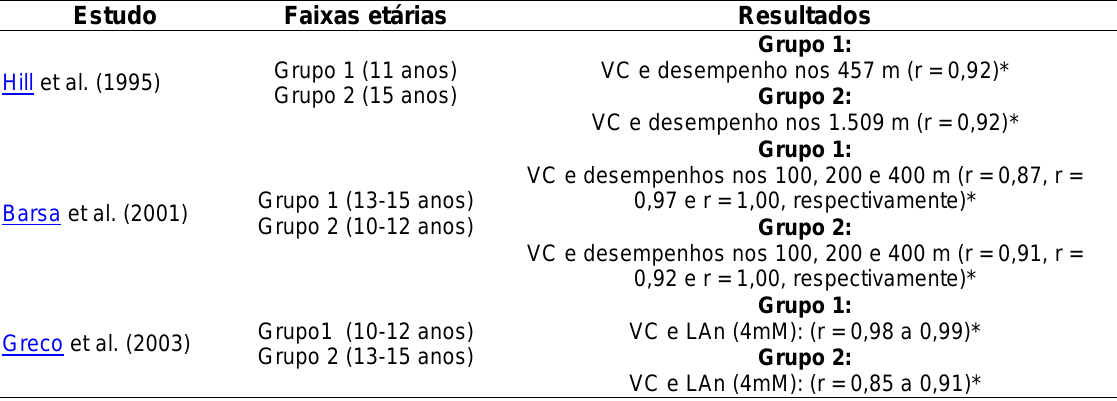
Tabela 3. Valores de correlação de grupos de nadadores com diferentes faixas etárias da VC com relação ao LAn e os desempenhos Faixas etárias